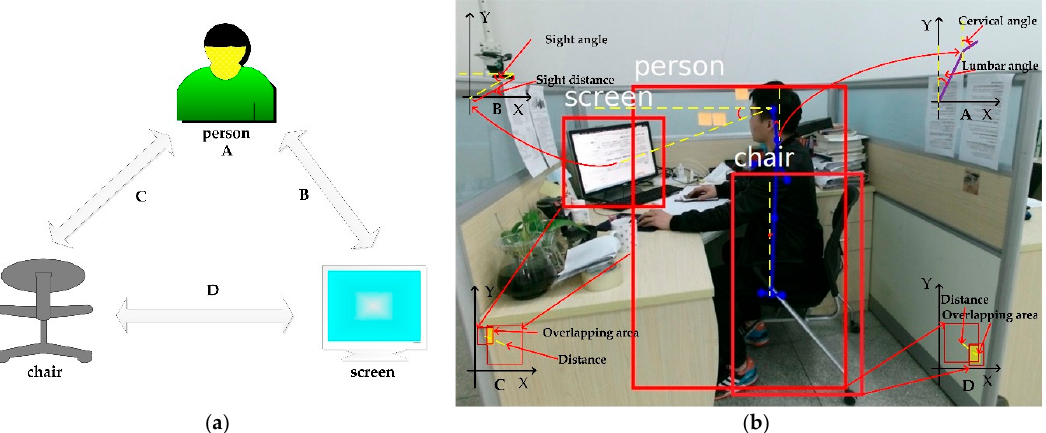
Figure 6. The diagram of semantic analysis. ( a ) The diagram of relevant semantic features; ( b ) The extraction method of semantic features A, B, C and D. A is extracted from human skeleton joints. B is extracted from person and screen. C is extracted from person and chair. D is extracted from chair and screen.